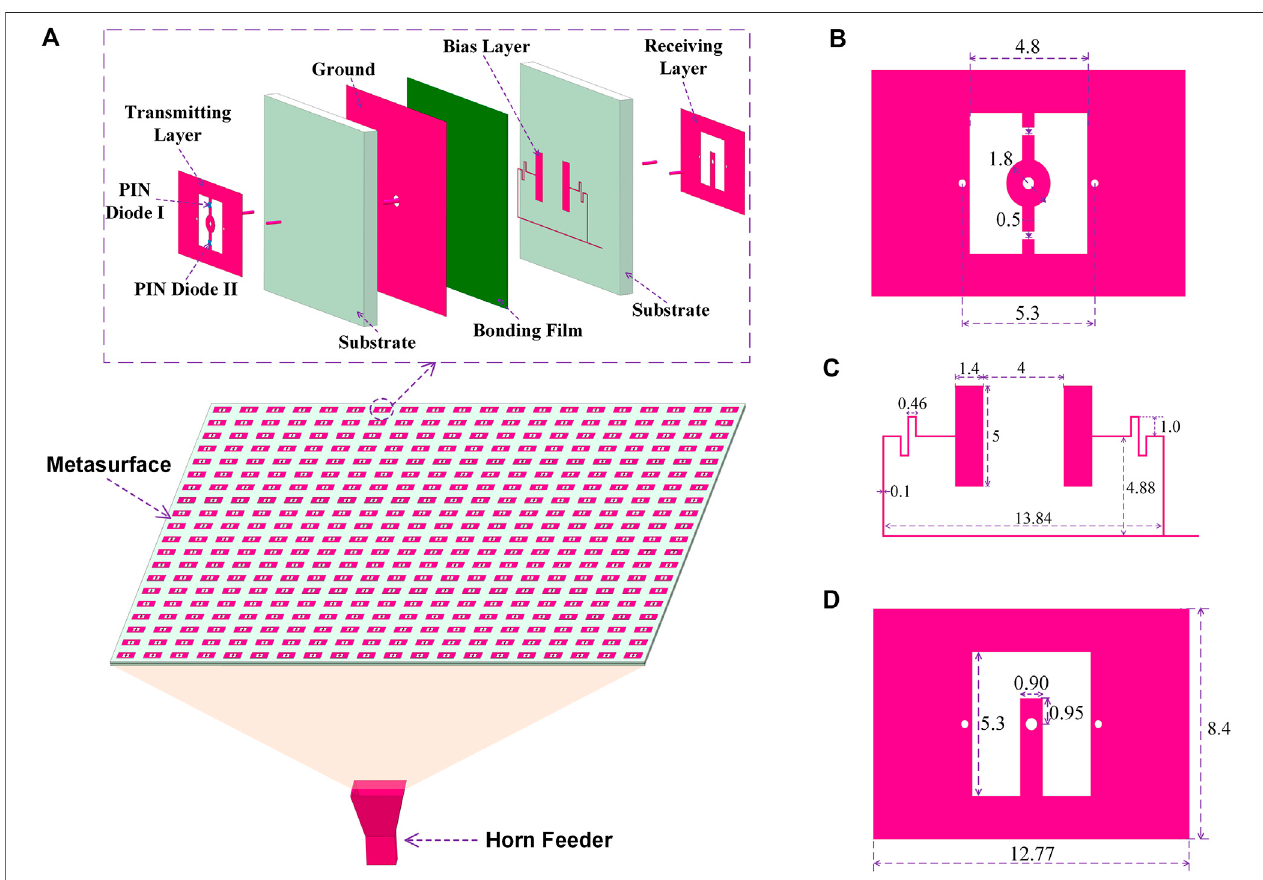
FIGURE 1 | Topological con fi guration of the proposed transmissive metasurface (all dimensions are in millimeters) (A) Exploded view of the 1-bit cell on top along with the metasurface at bottom (B) Transmitting layer (C) Bias layer (D) Receiving layer.